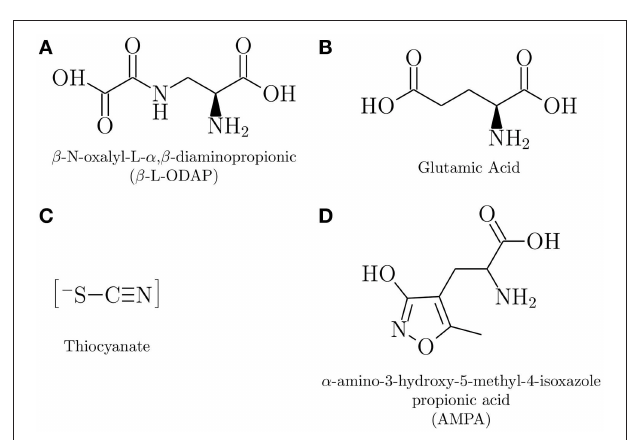
FIGURE 6 | Structures of lathyrism and konzo neurotoxins.